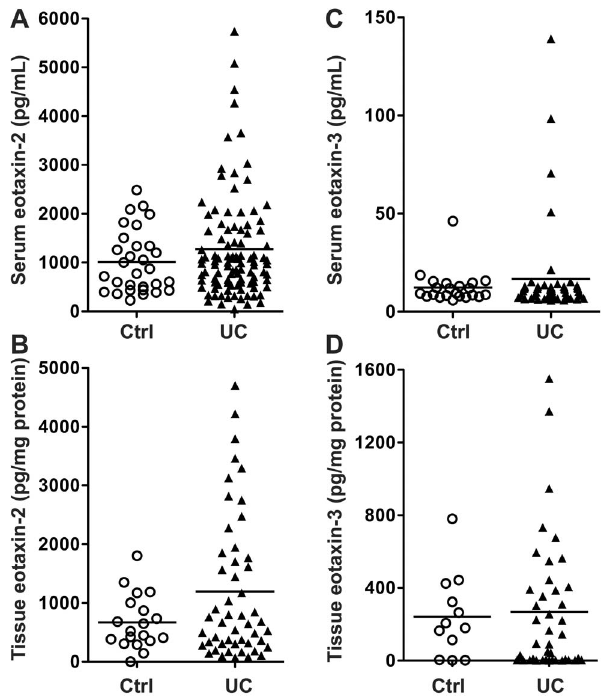
Figure 3. Eotaxin-2 and -3 levels in UC. Serum and tissue cytokine/ chemokine levels are based on Luminex assay using a custom kit for eotaxin-2 and eotaxin-3. (A – B) Serum levels. (C – D) Tissue levels. For serum, n =33 for control and n =101 for UC. For tissue, n =18 for control and n =50 for UC. Note that many samples did not have reliable eotaxin-3